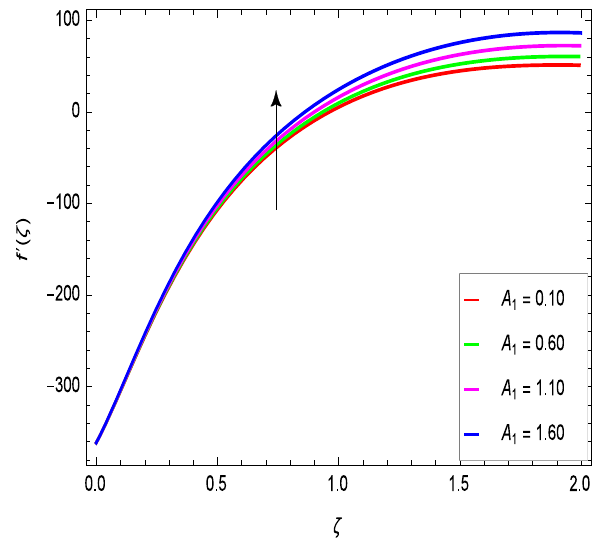
Figure 8. f ′ (ζ) in terms of A 1 .